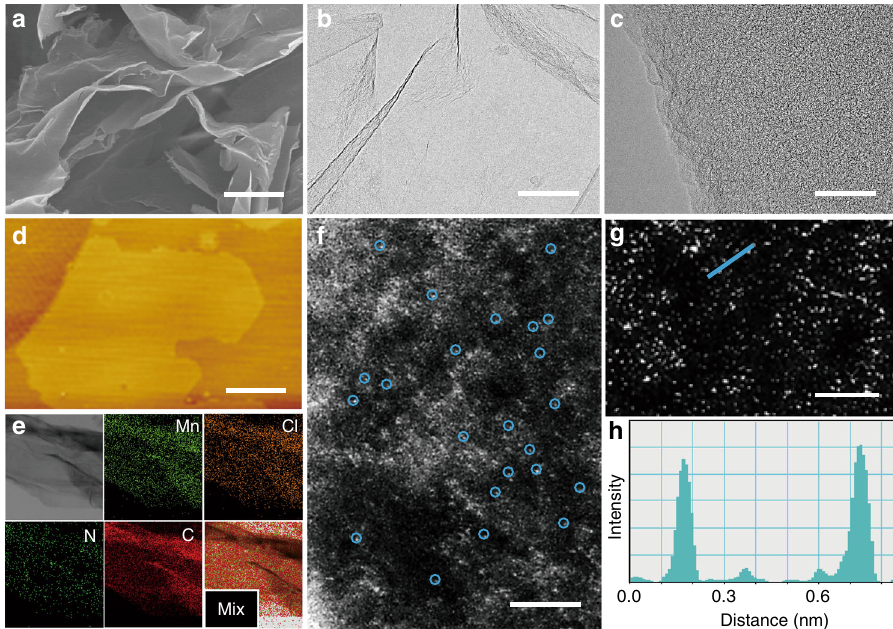
Fig. 1 Structural characterizations of (Cl, N)-Mn/G. a SEM image. b , c TEM images. d AFM image. e EDS image. f HAADF-STEM image. The high density bright dots (highlighted by blue circles) corresponding to single Mn atoms are homogeneously distributed across the entire carbon framework. g Enlarged HAADF-STEM image of Fig. 1f. h The corresponding intensity pro fi le along the line as shown in Fig. 1g. Scale bars, 1.5 µ m in ( a ), 200 nm in ( b ), 50 nm in ( c ), 800 nm in ( d ), 2 nm in ( f ) and 1 nm in ( g )